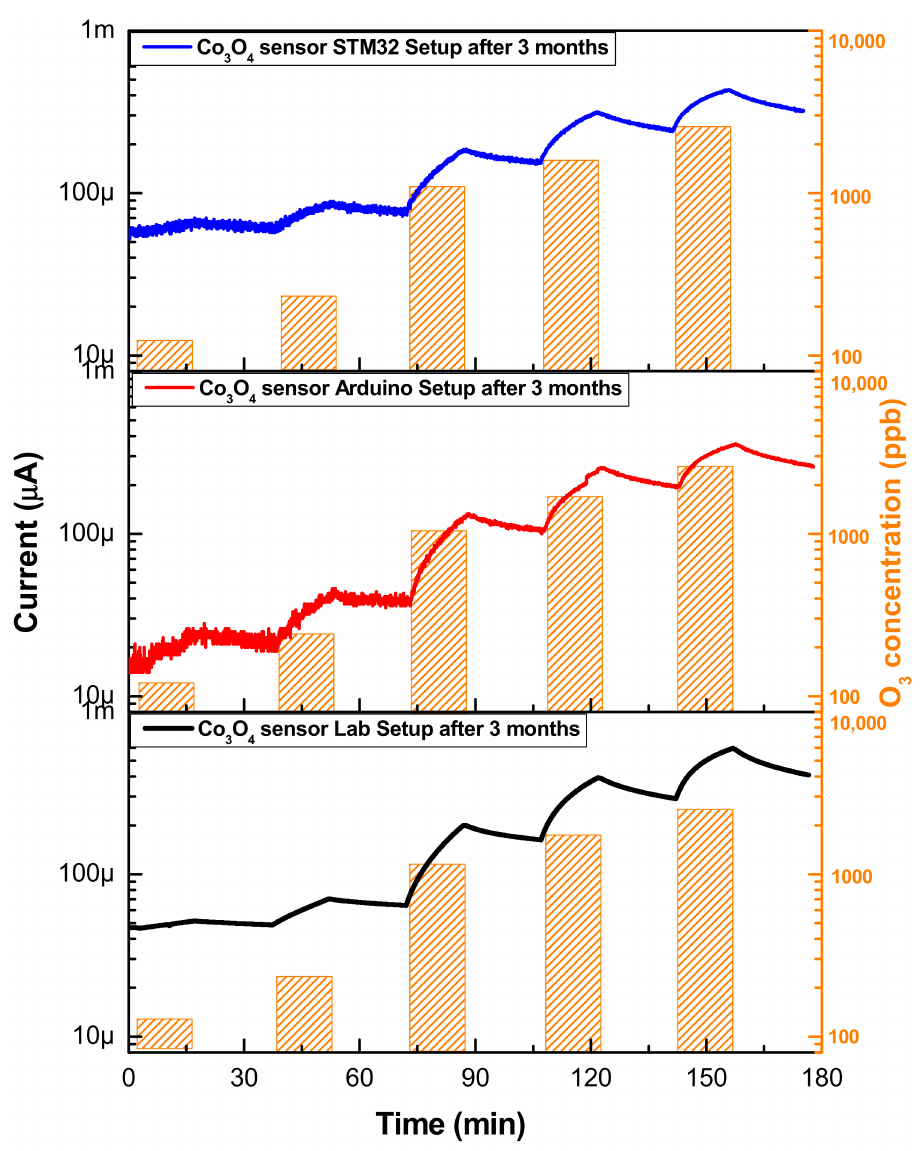
Figure 8. Electrical current variation of Co 3 O 4 sensor measured by three different setups towards 120–2600 ppb O 3 , at room temperature, after three months from its initial